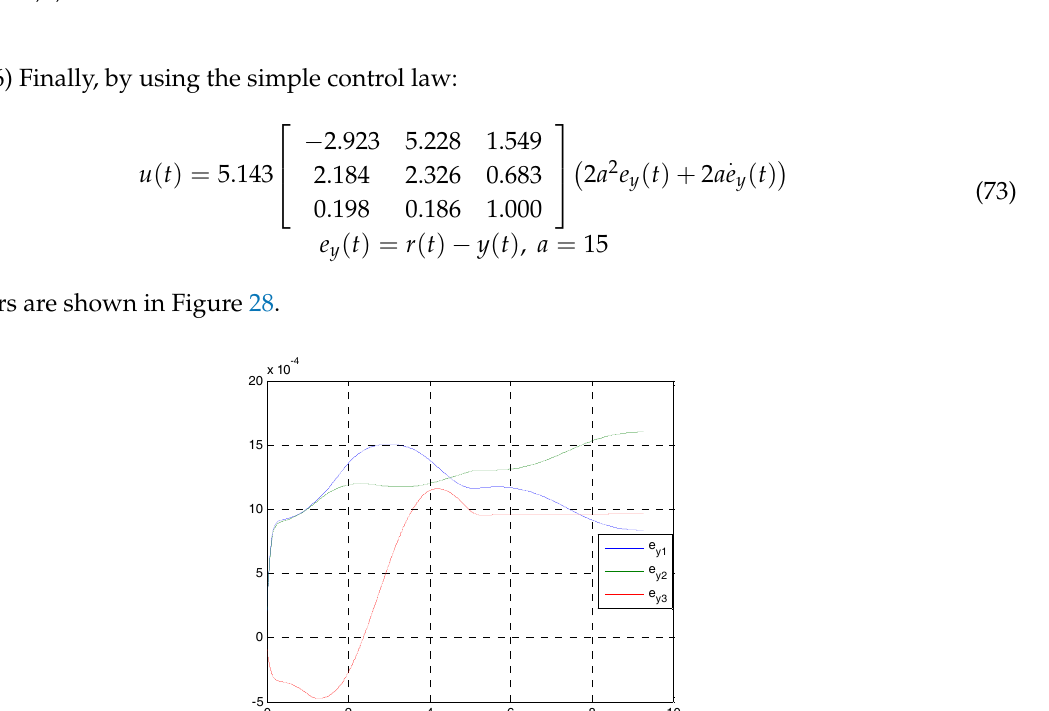
Figure 27. Time histories of the errors with the controller (72).